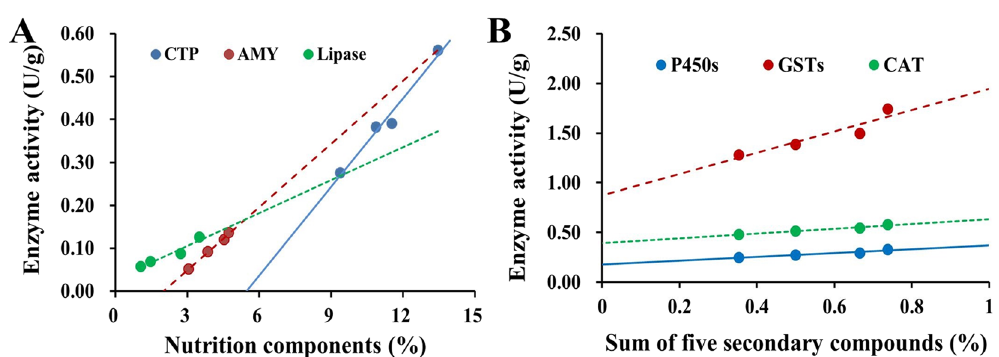
Figure 5. Linear relations between O. asiaticus mean enzyme activity and food plant chemical traits. ( A ) Relationship between mean chymotrypsin (CTP, U/g) activity and mean crude protein content, mean amylase (AMY, U/g) activity and mean starch content, mean lipase activity (U/g) and mean lipid content. ( B ) Relationship between cytochrome P450s (P450s, U/g), glutathione-S-transferase (GSTs, mU/g), carboxylesterase (CAT, mU/g) mean activities with the sum of five secondary compounds